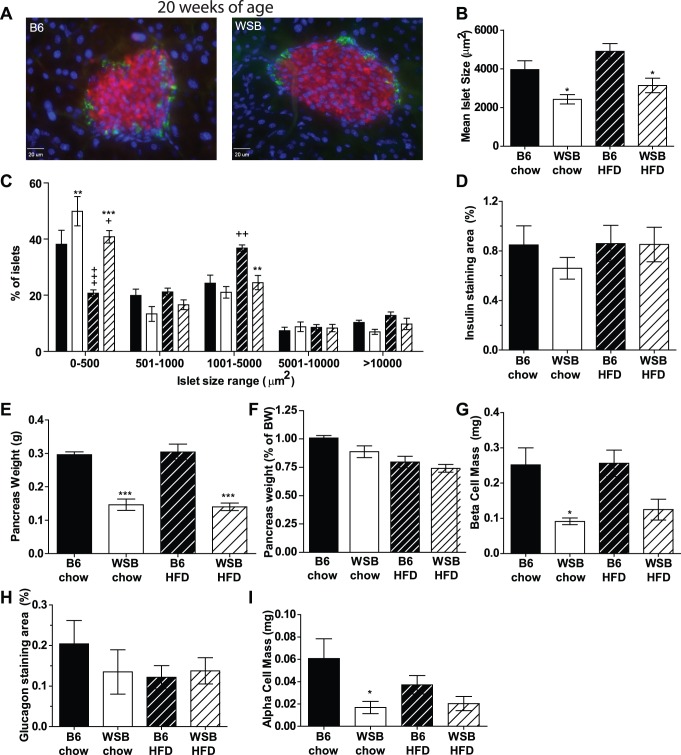
Islet structure and size, β-cell mass, and α-cell mass at twenty weeks of age.A. Representative islets from B6 (left) and WSB (right) mice fed the chow diet. Insulin is stained red, glucagon green, and cell nuclei are marked by DAPI staining (blue). No alteration to islet structures was found in islets from the high fat-fed mice. B. The average cross-sectional areas of all islets found in each mouse were determined then averaged for each strain (average number of islets per mouse examined: B6 chow- 167, B6 HFD 187, WSB chow 129, WSB HFD 171). C. Distribution of islet sizes in B6 (black; chow-fed solid, high fat diet (HFD)-fed striped) and WSB mice (white; chow-fed solid, high fat diet (HFD)-fed striped). In the upper group, although there was substantial overlap in the sizes, B6 mice tended to have larger maximal islet sizes (both diets). D. Percent of pancreatic tissue area stained for insulin. E. Pancreatic weight of mice used in these experiments. F. Pancreatic weights normalized to total body weight in chow and high fat-fed WSB and B6 mice. G. β-cell mass, calculated as the % staining area multiplied by the pancreatic weight. H. Percent of pancreatic area stained for glucagon. I. α-cell mass calculated as for β-cell mass. (n = 5 mice per strain per diet). *p<0.05, **p<0.01, ***p<0.001 vs. B6 mice consuming the same diet. +p<0.05, +++p<0.001 vs. chow-fed of the same strain.